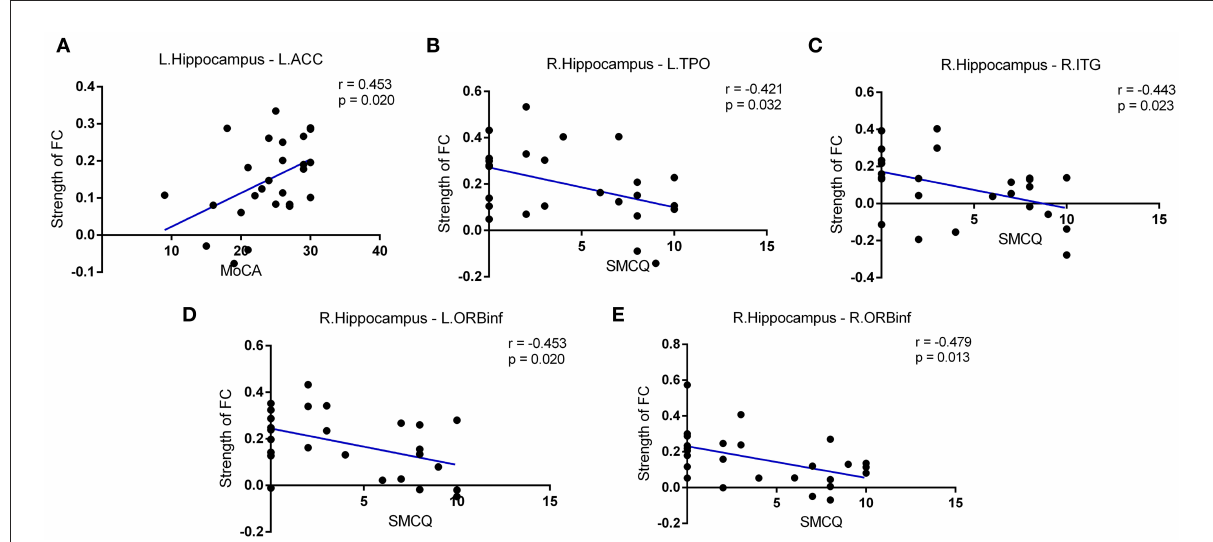
FIGURE4 Correlations between intrinsic connectivity strength and cognitive function in patients after the rupture of ACoA aneurysm. (A) Positive correlation between MoCA scores and connection between left hippocampus-left ACC. Negative correlations between SMCQ scores and right hippocampus-left TPO (B) , right hippocampus-right ITG (C) , and right hippocampus-bilateral ORBinf (D,E) connectivity strength. ACoA, anterior communicating artery; MoCA, Montreal Cognitive Assessment; ACC, anterior cingulate cortex; SMCQ, Subjective Memory Complaints Questionnaire; ITG, inferior temporal gyrus; TPO, temporal pole; ORBinf, orbital part of inferior frontal